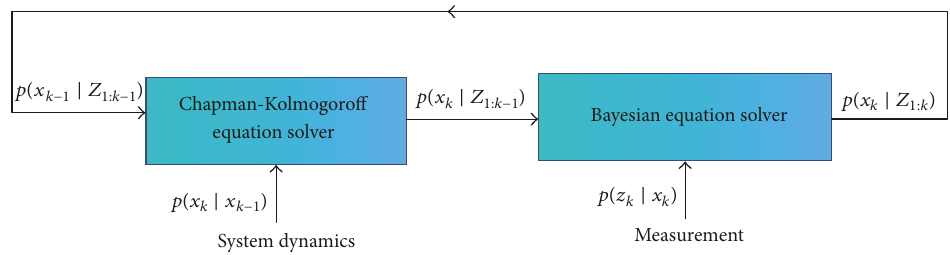
Figure 1: One cycle of Bayesian recursive estimation algorithm